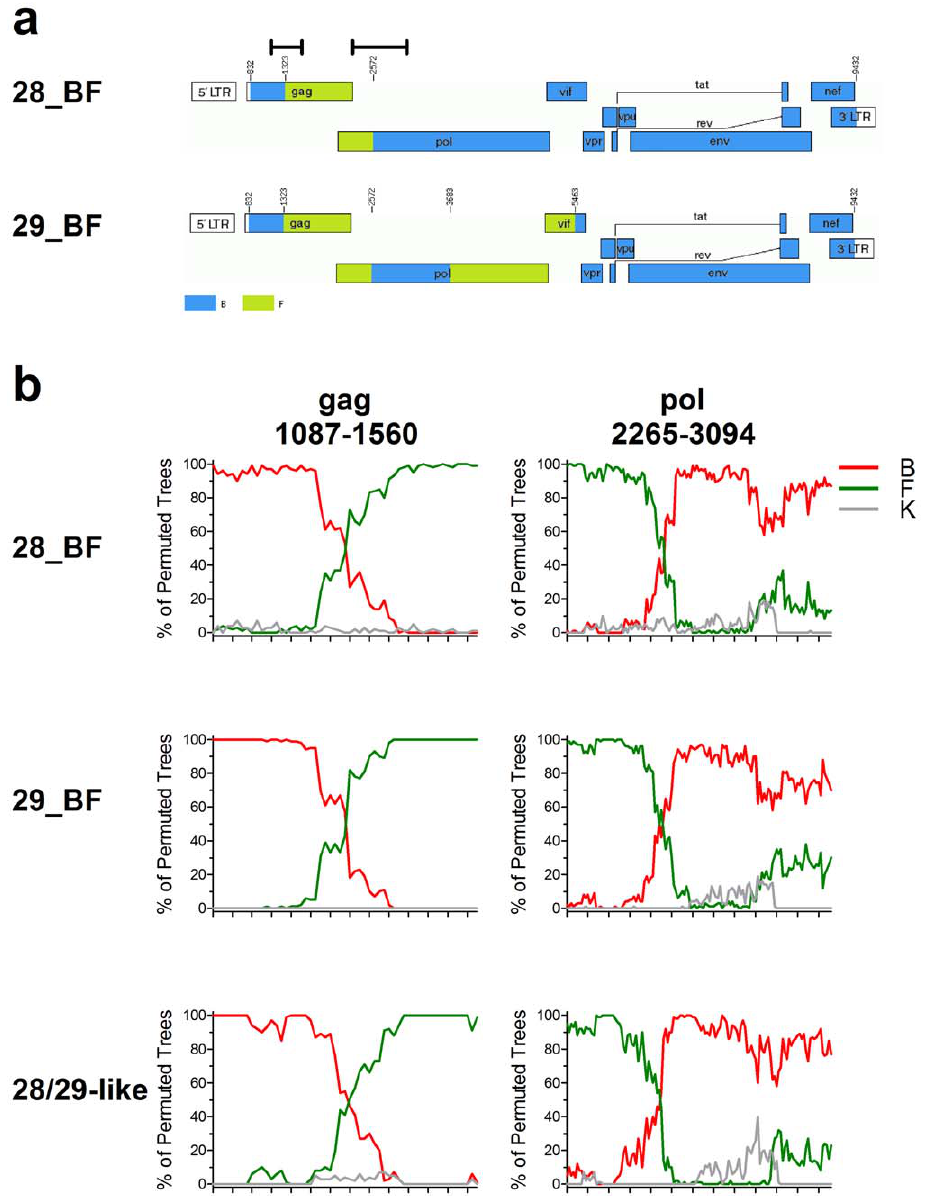
Figure 1. Mapping the recombination breakpoints of CRF. (A) Recombination patterns of the CRF28_BF and CRF29_BF genomes. The number at each recombination breakpoint indicates the nucleotide position according to HXB2 numbering. Blue, subtype B; Green, subtype F1. Black bars above the HIV-1 genome indicate the gag (1,087–1,560) and pol (2,265–3,904) regions analyzed in this study and in the subsequent bootscanning analyses. (B) The bootscanning of CRF28_BF, CRF29_BF and CRF28/29_BF-like recombinant genomes revealed a similar recombination breakpoint. The recombinant sequences identified in RIP were subjected to bootscanning, and representative results are shown. The query sequence was compared with subtype B, F1 and K consensuses obtained from RIP, and plots of percentages of permuted trees against nucleotide positions are shown. Red, subtype B; green, subtype F1, grey, subtype K. A window/step size of 200/10 was used to analyze the sequences.